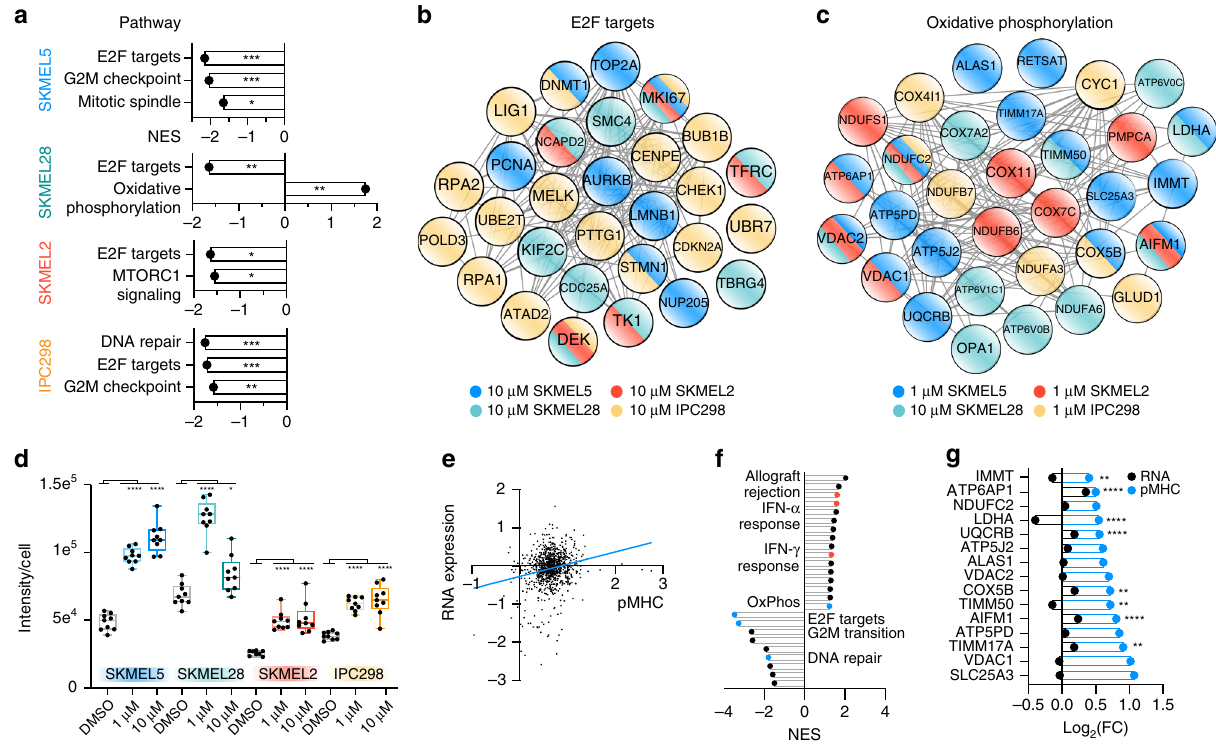
Fig. 5 Pathway analysis of palbociclib-altered immunopeptidome. a Normalized enrichment score (NES) of signi fi cantly enriched pathways with 10 μ M palbociclib, where + / − NES scores re fl ect enrichment directionality. For all, q < 0.25, and * p < 0.05, ** p < 0.01, and *** p < 0.001. b , c String network of protein – protein interactions of all source proteins from E2F peptides ( b ) signi fi cantly decreasing with 10 μ M palbociclib, and OxPhos peptides ( c ) signi fi cantly increasing with 1 μ M palbociclib for all cell lines, except SKMEL28, where peptides from 10 μ M are depicted. Node color corresponds to cell line. d Quanti fi cation ( n = 9) of MitoTraker green intensity normalized to cell number following 72 h palbociclib treatment. Data are represented as a box and whiskers plot, with whiskers displaying minimum and maximum signal. Signi fi cance was determined using Dunnett ’ s multiple comparisons test for each condition versus DMSO. * p < 0.05 and **** p < 0.0001. e Correlation between log 2 fold change (FC) of (palbociclib/DMSO) for RNA expression ( y -axis) and pMHC presentation ( x -axis) of SKMEL5 cells treated for 72 h with 1 μ M palbociclib, r 2 = 0.04. FC is calculated from the mean intensity of n = 3 biological replicates per condition. f Signi fi cantly enriched pathways using RNA-seq data ( p < 0.05, q < 0.25). Annotated pathways re fl ect pathways also identi fi ed in the immunopeptidome analysis (blue), and those that match with previous reported data (red) 7 . g Log 2 (FC) for SKMEL5 OxPhos peptides signi fi cantly increasing ( p < 0.05, blue) with 1 μ M palbociclib, and matched log 2 (FC) of RNA expression (black). Signi fi cant differences in RNA expression (palbociclib versus DMSO) are indicated. ** p < 0.01 and **** p < 0.0001 (Wald test, Benjamini – Hochberg (BH) adjusted). Exact signi fi cance values and other Source data are reported in the Source Data